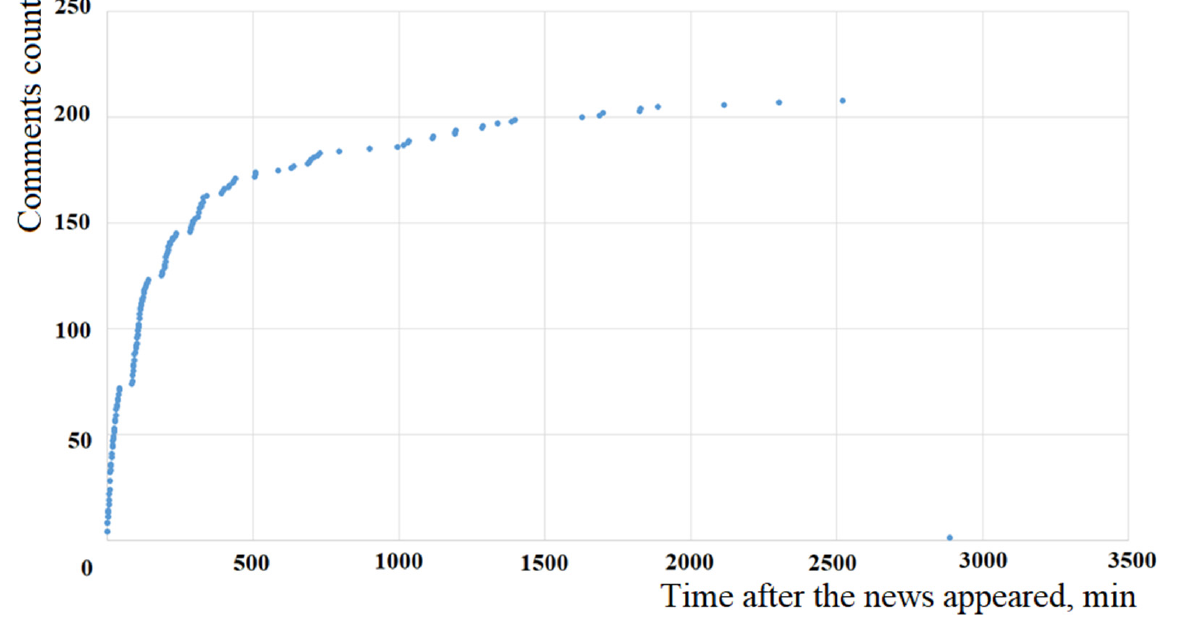
Figure 10. Dynamics of changes over time, the number of comments on a news item of public interest that appeared on the portal https://echo.msk.ru/news/2571431-echo.html, accessed on 15 January 2020, after removing the time gaps.